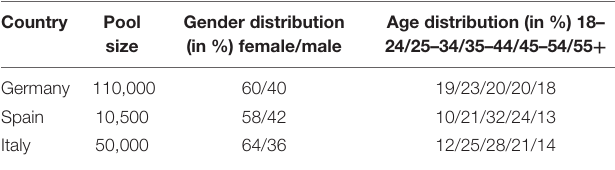
TABLE 1 | Overview of the sample pools in